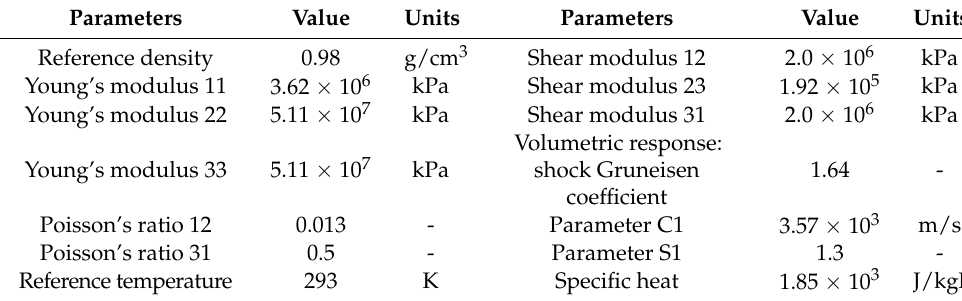
Table 5. Material constants for orthotropic equation of state.